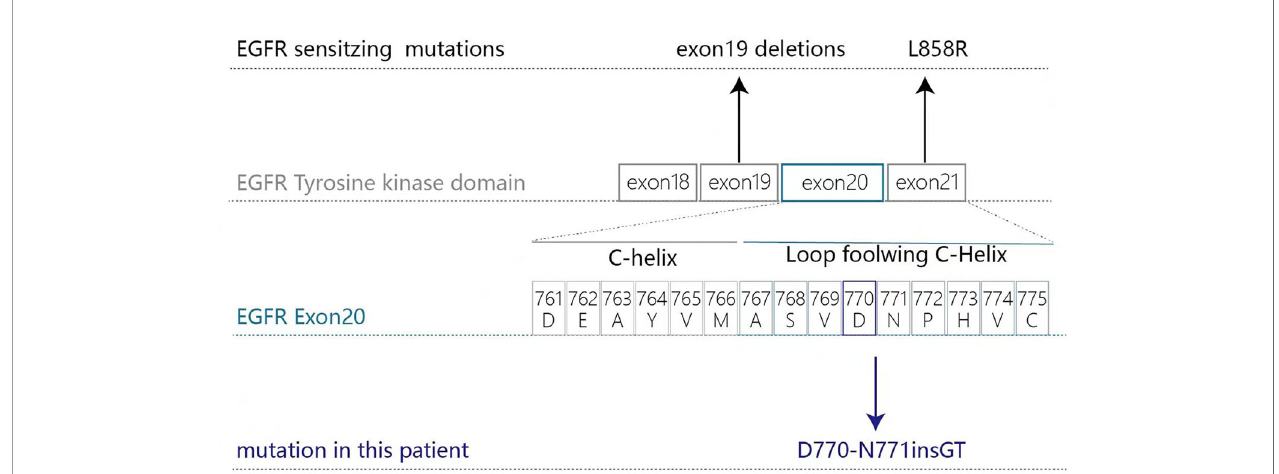
FIGURE 1 | Gene check analysis showed that the patient had an EGFR exon20 insertion (p.D770-N771insGT)